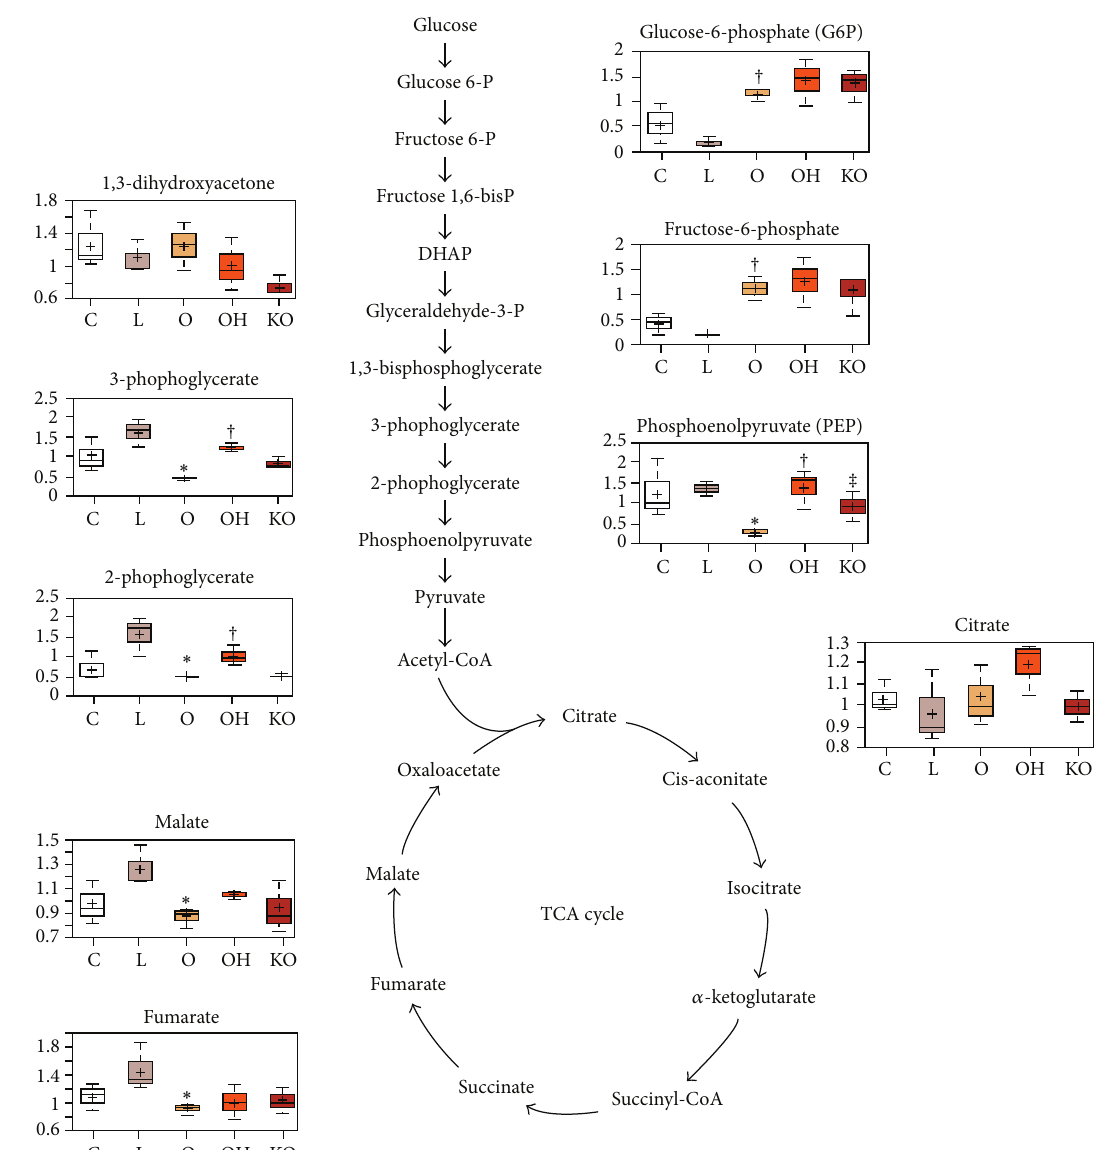
Figure 3: Variations in the metabolites of the glycolytic pathway and tricarboxylic acid cycle in HUVEC cell homogenates ( 𝑛 = 3 , for each experiment). Endothelial cells were incubated over 24 h with 50 mg/L isolated human LDL (L); 50mg/L oxidized LDL (O); 50 mg/L oxidized LDL + 40mg/L HDL from wild type mice (OH); 50mg/L oxidized LDL + 40 mg/L HDL from PON1 (−/−) mice (KO); or with serum-free media as controls (C). ∗ 𝑃 < 0.05 with respect to L; † 𝑃 < 0.05 with respect to O; ‡ 𝑃 < 0.05 with respect to